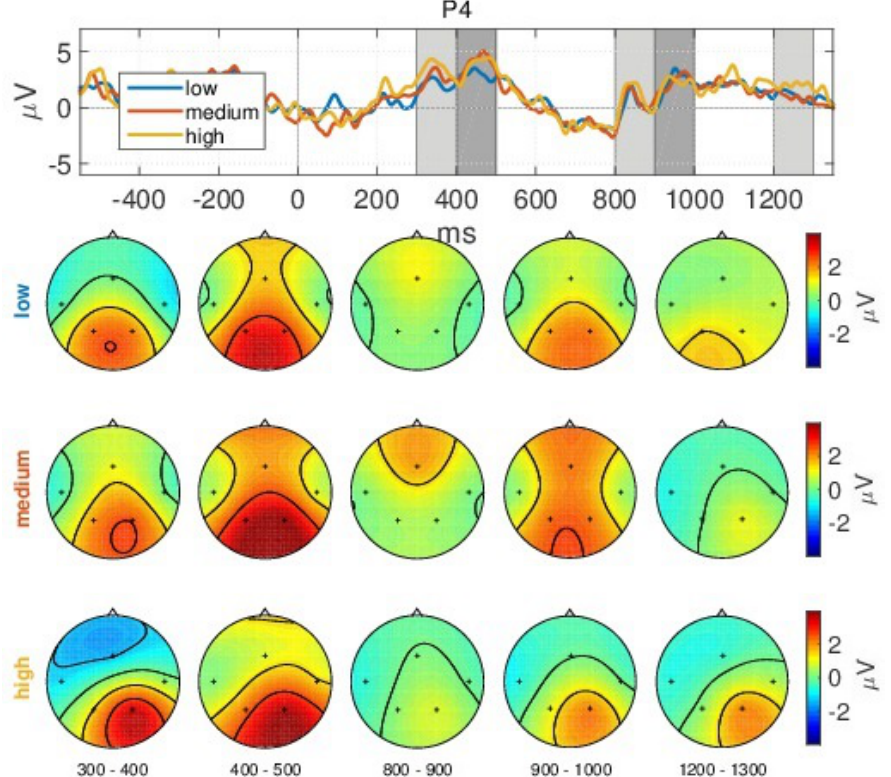
Figure 6. GA ERP for Nat images corresponding to the 3 complexity levels according to CE, at channel P4 and the scalp topographies at 300–400 ms, 400–500 ms, 800–900 ms, 900–1000 ms, and 1200–1300